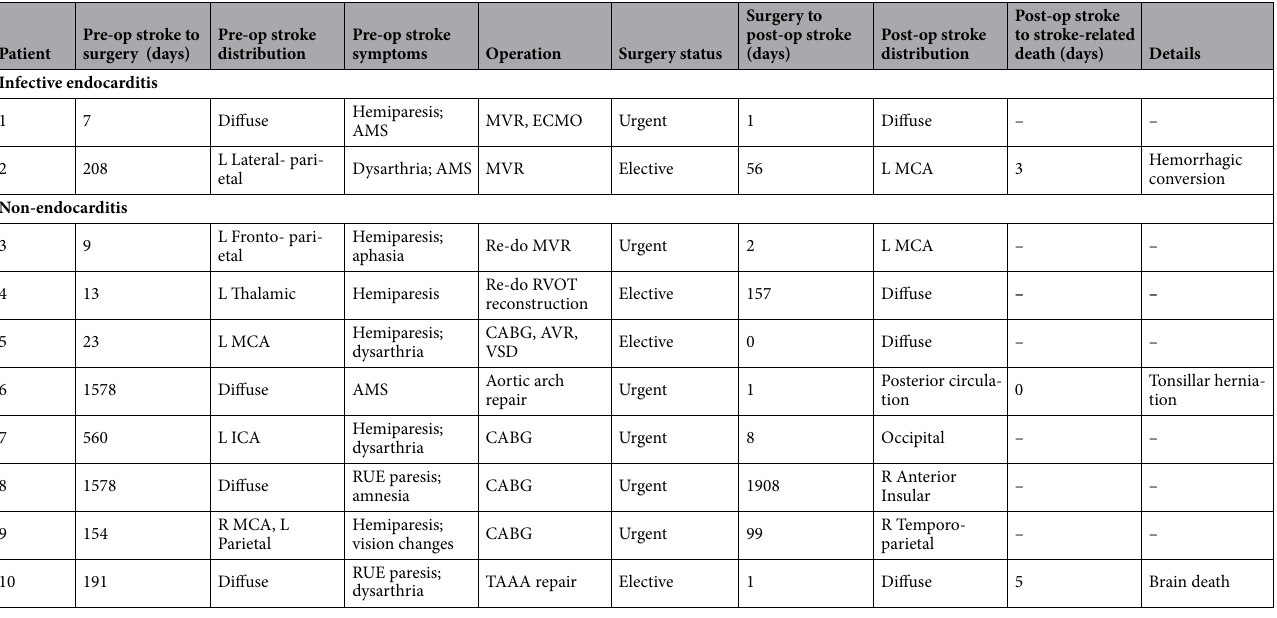
Table 4. Details of study subjects who had postoperative stroke. L left, R right, AMS altered mental status, MVR mitral valve replacement, ECMO extracorporeal membrane oxygenation, CABG coronary artery bypass